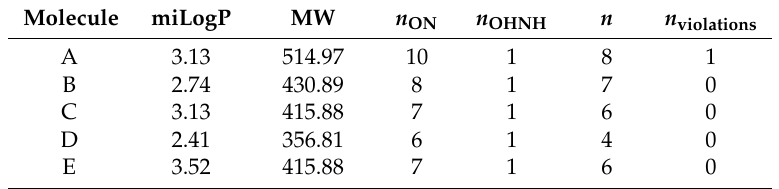
Table 4. Calculated parameters of the Lipinski rule of five for the proposed